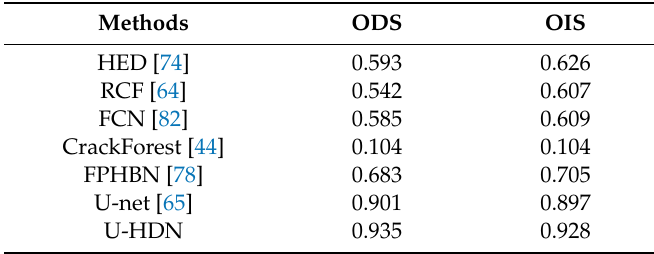
Table 5. The ODS, and OIS of comparison methods on